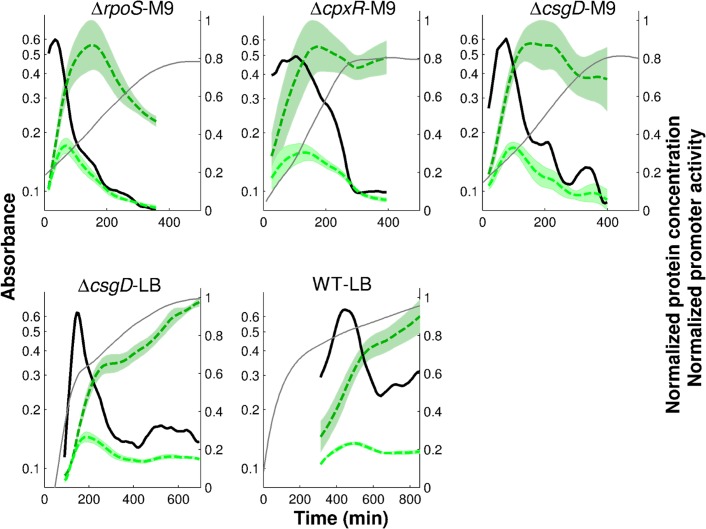
Estimates of FliA concentrations from reporter gene data.Concentrations of FliA computed from fliA promoter activity (thick, black solid line) in all experimental conditions considered in this study. The fliA activities are the same as shown in Fig. 3. The dashed, dark green line represents the concentration of the reporter protein, while the dashed, light green line represents the reconstructed FliA concentration for the measured half-live of 30 min. In each condition, promoter activity has been normalized with respect to its maximum value. The protein concentrations have been normalized with respect to the maximum of the upper limit of the confidence interval of the reporter concentration. The shaded regions correspond to the mean of the protein concentrations ± twice the standard error of the mean. For clarity, the confidence intervals of the promoter activities have been omitted.